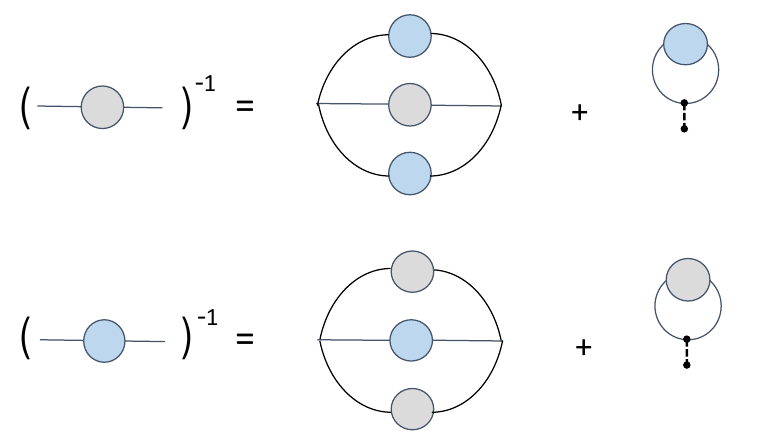
(x 12 ) of the chiral Majorana (cid:6) (grey). (cid:0)